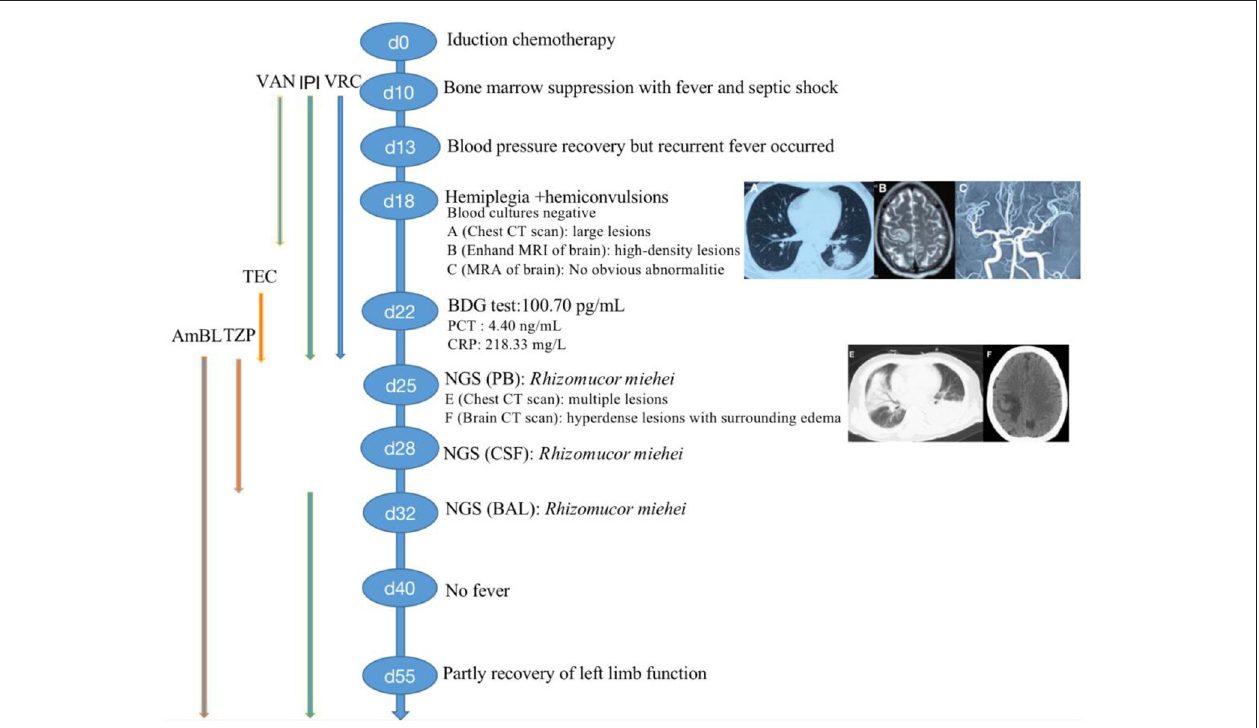
FIGURE 1 | Clinical course of the patient (schematic). BDG, (1,3)-b-D-glucan; PCT, procalcitonin; CRP, c-reactive protein; CT, computed tomography; MRI, magnetic resonance imaging; MRA, magnetic resonance angiography; VRC, voriconazole; IPI, Imipenem; VAN, Vancomycin; TEC, teicoplanin; AmBL, liposome-associated amphotericin B; mNGS, metagenomics next-generation sequencing; PB, peripheral blood; CSF, cerebral spinal fluid; BAL, bronchoalveolar lavage